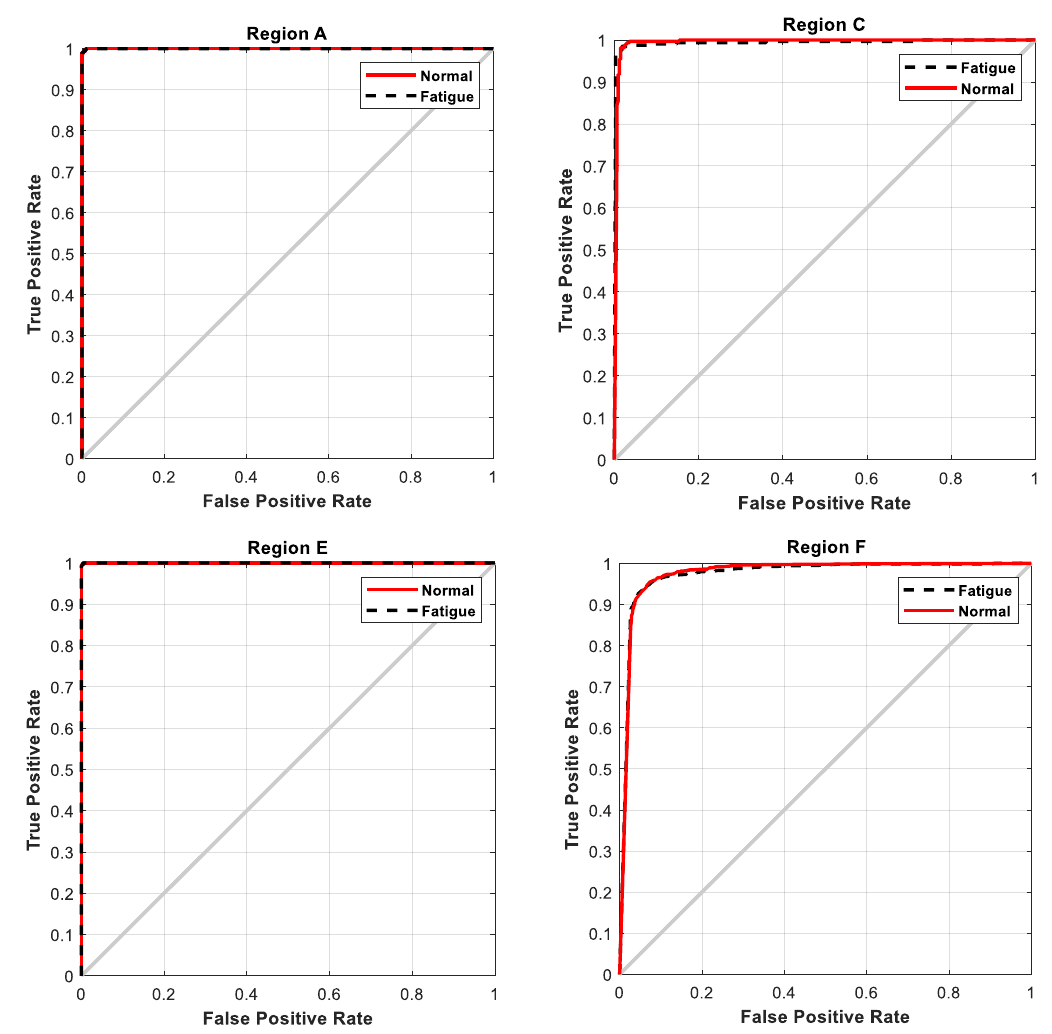
Figure 12. The receiver operating characteristic (ROC) analysis for regions A, C, E, and F. Moreover, Figure 13 demonstrates the t-sen diagram of the raw signal, Conv3, Conv7, LSTM1, LSTM3, and FC1 layers for the testing data of region E. The final layer indicated